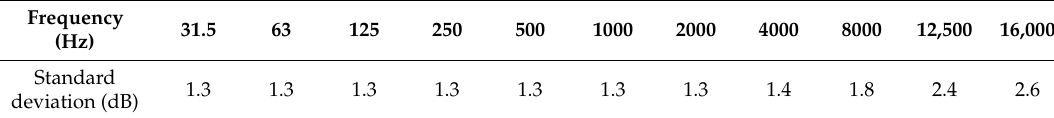
Table 4. Standard Deviation for the frequency